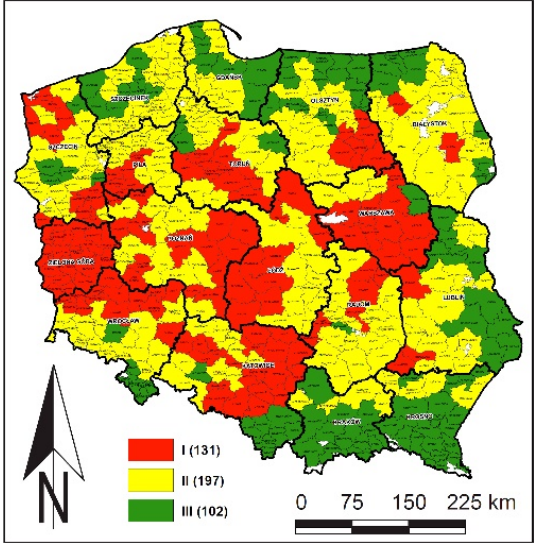
Figure 7. Assessment of potential fire hazard in Polish forests according to forest district (I, II, III—categories of forest fire hazard, as of 31 December 2018).